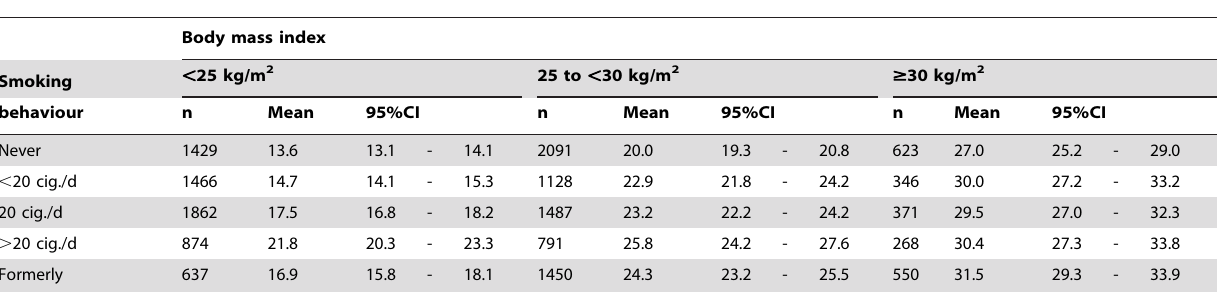
Table 3. Geometric mean c -GT (U/L at 25 u C) according to smoking and body mass index category.